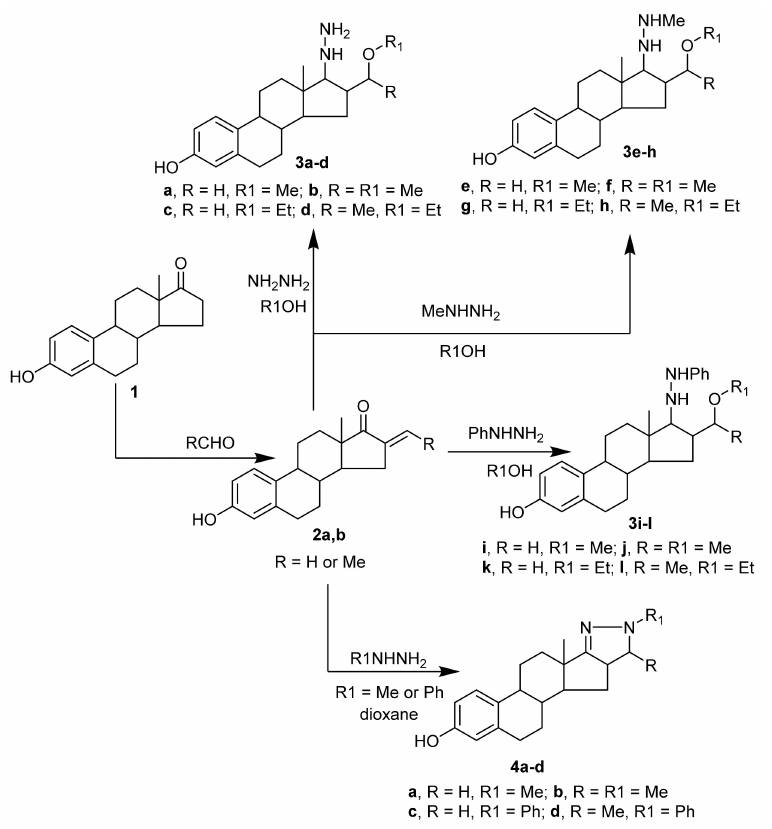
Scheme 1. Synthetic route for compounds 2 – 4